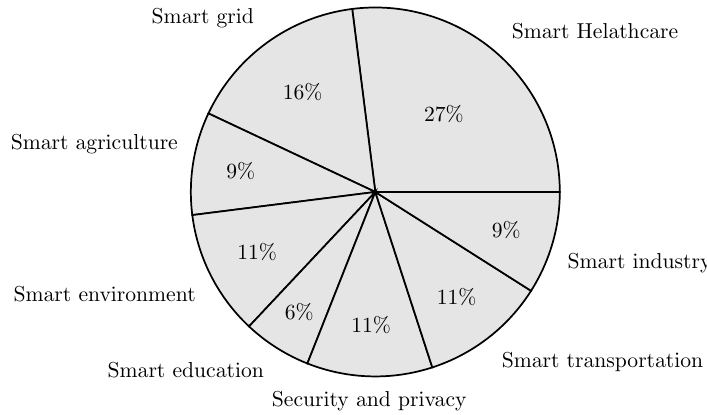
Figure 2. A statistic distribution of the domains considered in this